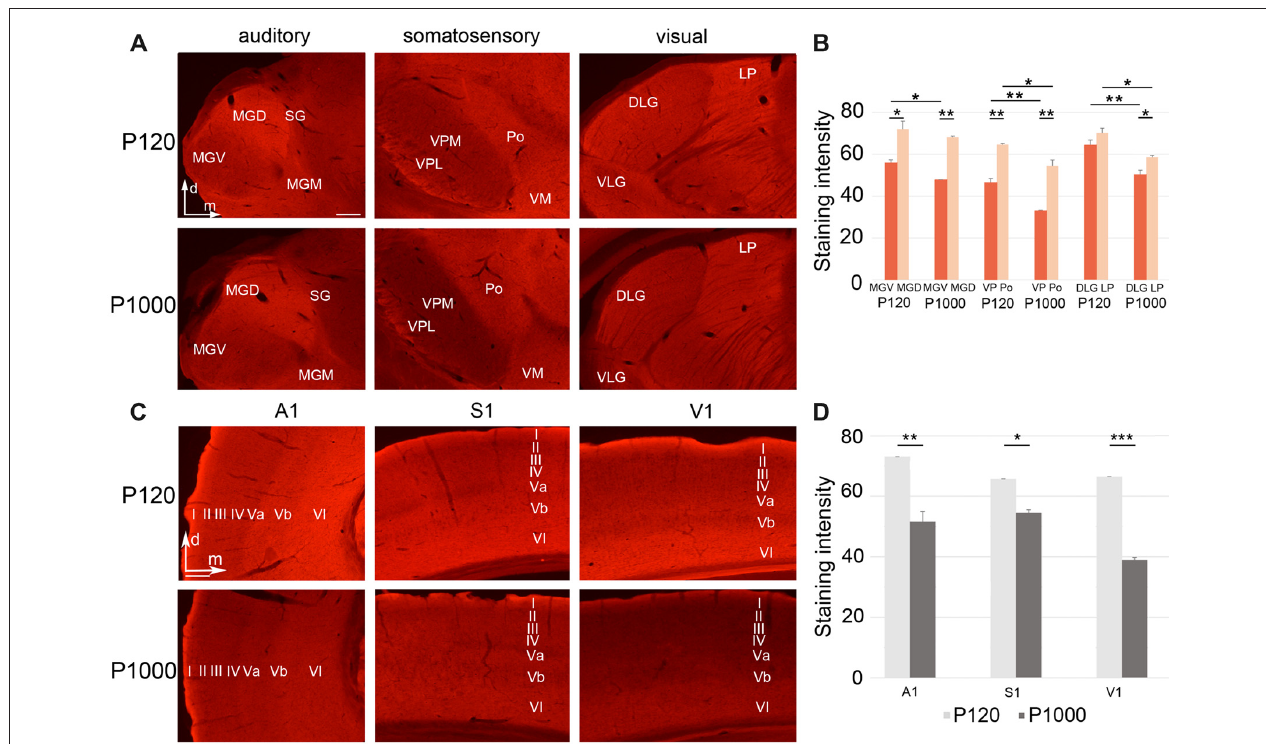
FIGURE 5 | Growth associated protein 43 (GAP43) levels in thalamic nuclei and primary sensory cortices generally decrease with age. (A,C) Frontal sections showing GAP43 labeling in the auditory, somatosensory, and visual thalamic nuclei (A) and primary sensory cortices (C) at P120 and P1000. Scale bars 200 µ m. (B,D) Average staining intensity of GAP43 in the sensory thalamus (B) and primary sensory cortices (D) at P120 and P1000. Note that the GAP43 levels are always higher in non-lemniscal nuclei (MGD, Po, LP) than in lemniscal nuclei (MGV, VPL/VPM, DLG). Staining intensities are mean gray values ± 1 SEM; stars indicate significant changes between structures and/or experimental ages ( ∗ p ≤ 0.05, ∗∗ p ≤ 0.01, ∗∗∗ p ≤ 0.001, Student’s t -test; n = 9 sections per group). Abbreviations: A1, primary auditory cortex; D/VLG, dorsal/ventral lateral geniculate nucleus; LP, lateral posterior thalamic nucleus; MGD/M/V, dorsal/medial/ventral part of the MGB; Po, posterior thalamic nucleus; S1, primary somatosensory cortex; SG, suprageniculate thalamic nucleus; V1, primary visual cortex; VM, ventromedial thalamic nucleus; VPL/M, ventral posterolateral/posteromedial thalamic